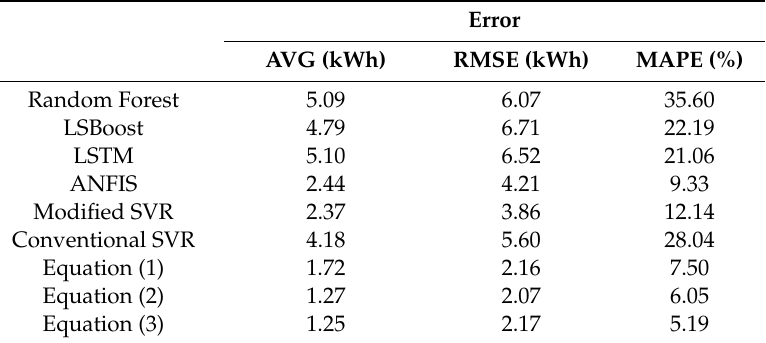
Figure 10. Comparison of the percentage error in the prediction of all the methods for all days. Table 8. Errors of predicted systems.